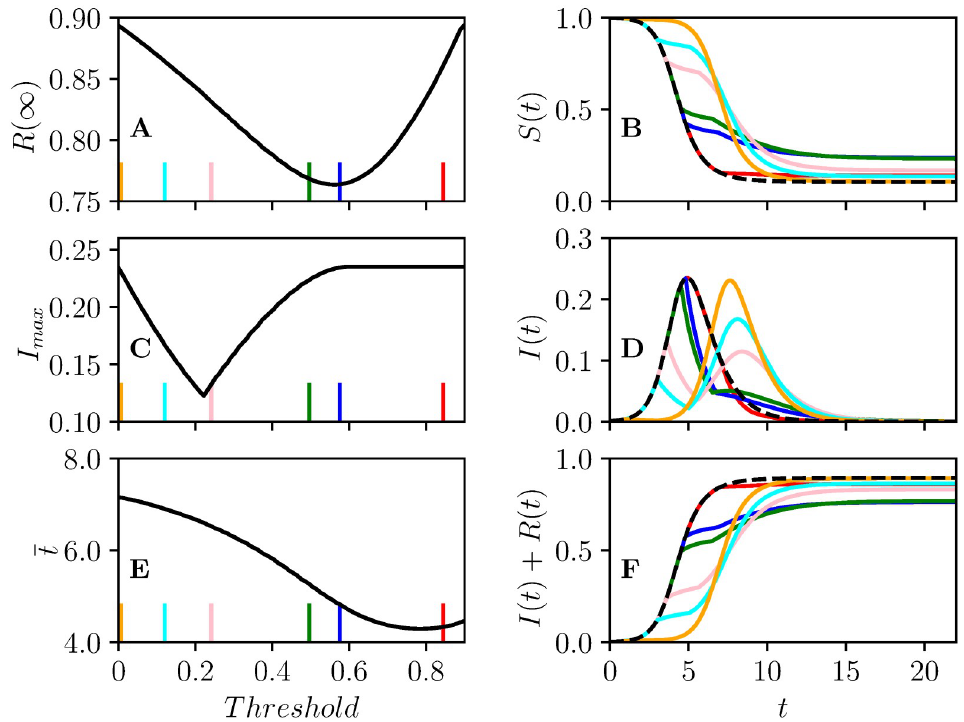
Fig 2. Illustration of the impact of one-shot intervention in a population with R for a duration of D = 2 time units. This intervention is introduced at different times as determined by a range of Threshold values. The impact of the threshold ( I + R > Tr ) for implementing the intervention is shown for A the attack rate R ( 1 ); B S ( t ); C peak prevalence I max ; D I ( t ); E average time of infection � t ; and F plots of I ( t ) + R ( t ). In (B,D,F), the no-control case is plotted as a dashed line. The vertical lines in (A,C,E) correspond to the threshold for cumulative infections I + R which yields the intervention leading to the corresponding color in (B, D, F).